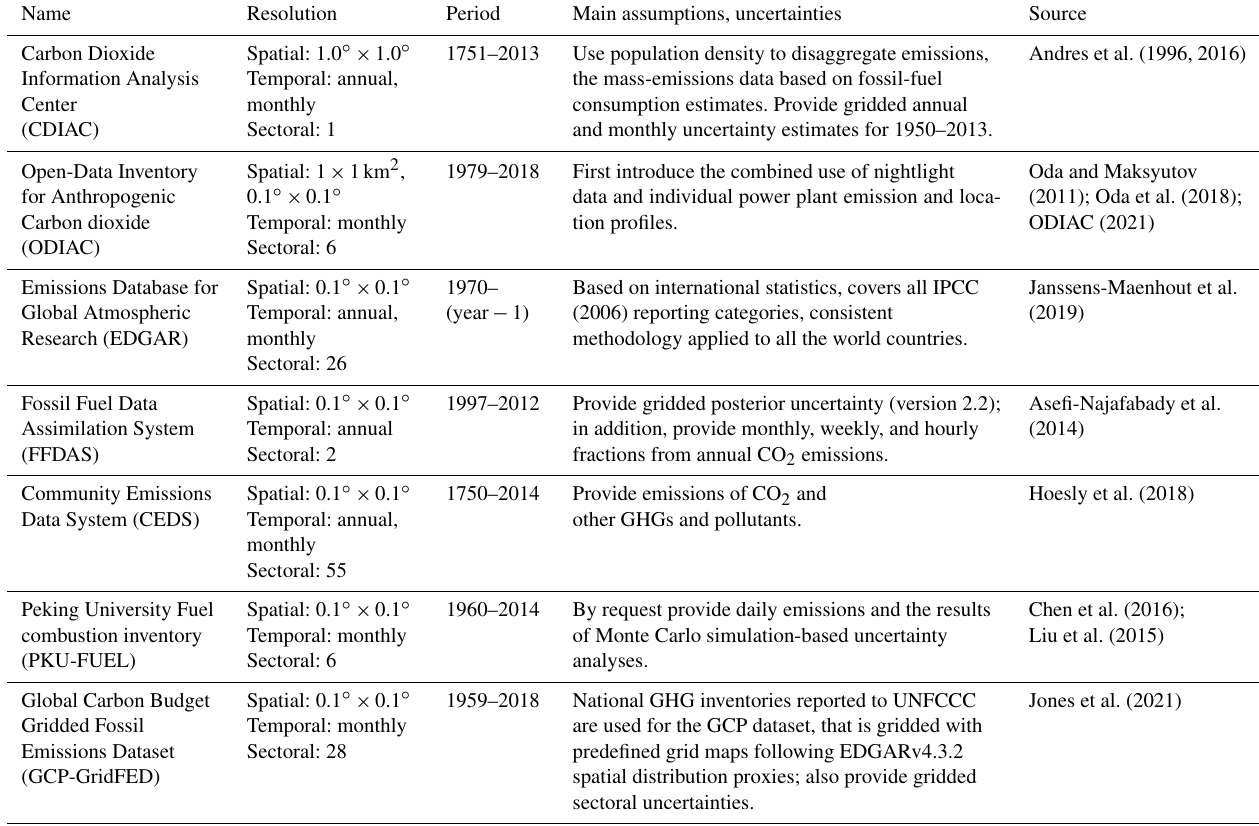
Table 1. Examples of global gridded anthropogenic CO 2 emission bottom-up